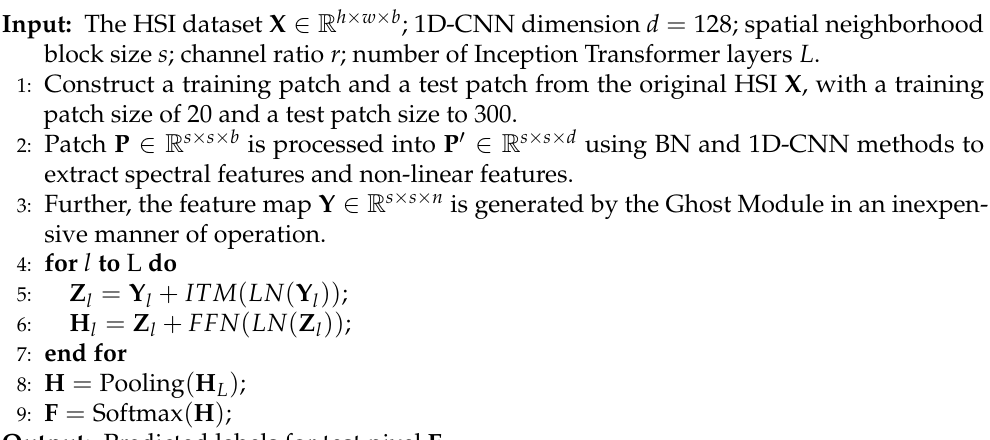
Figure 1. The structure of the proposed IFormer. φ represents the cheap operation and (cid:76) denotes the concatenate operations. Algorithm 1 IFormer method for HSI classification